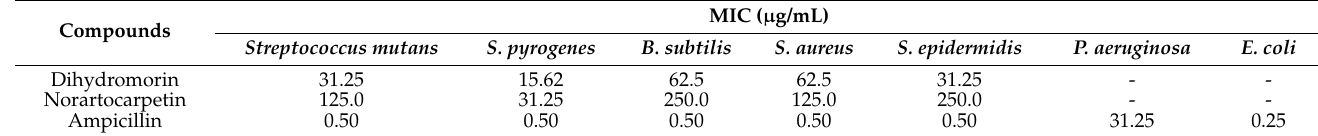
Table 17. Antibacterial activity of flavonoids from Artocarpus heterophyllus .